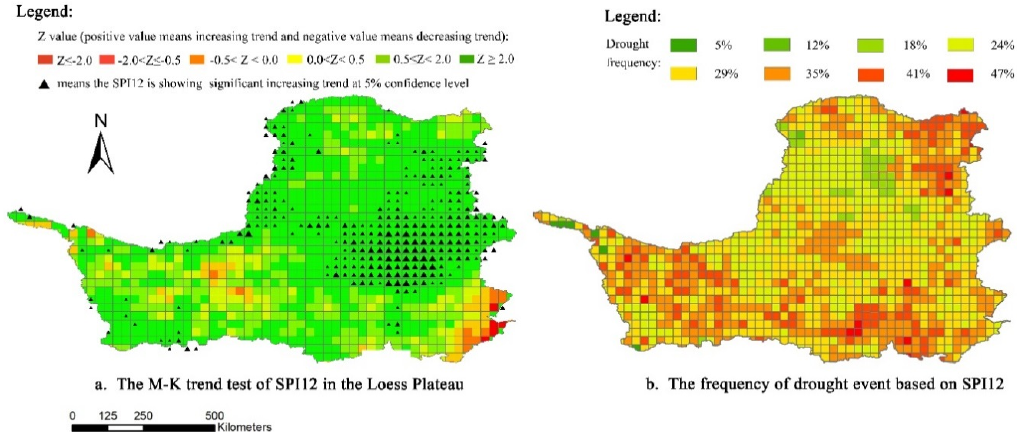
Figure 8. The spatial distribution of Z value and the frequency of drought event. When Z > 0, the SPI12 is on an increasing trend. When Z < 0, the SPI12 is on a decreasing trend. The black triangle means that the trend is significant at 95% confidence level.